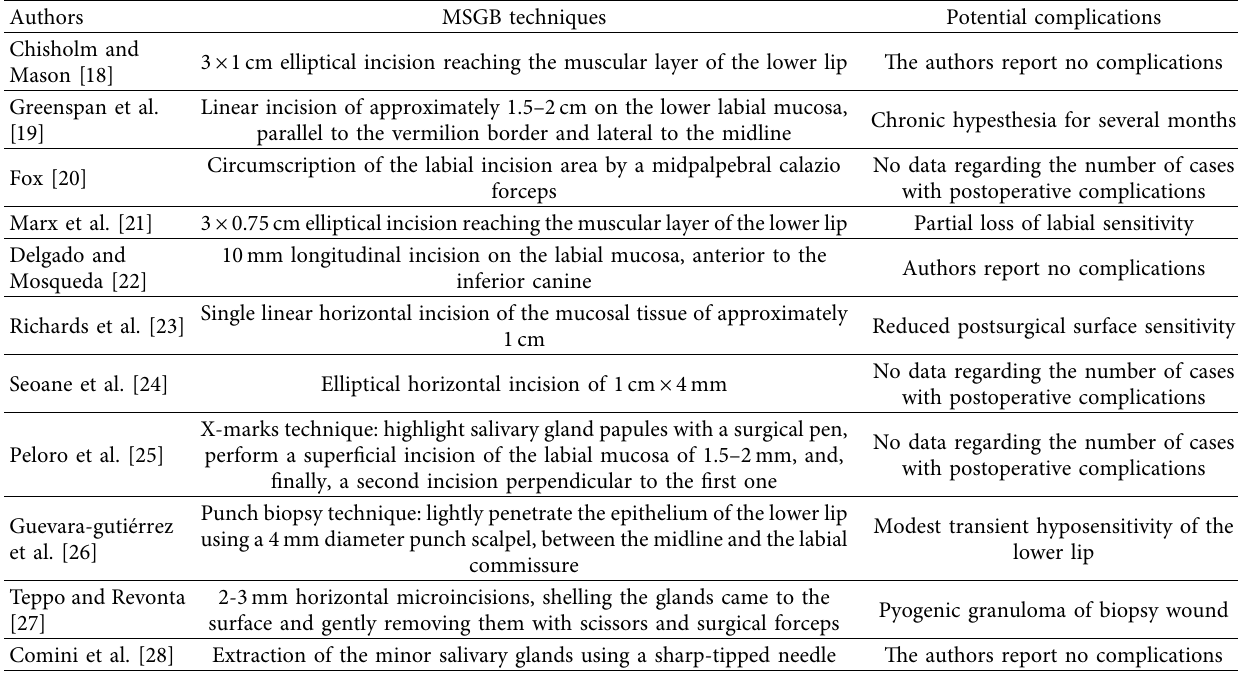
Table 5: MSGB techniques